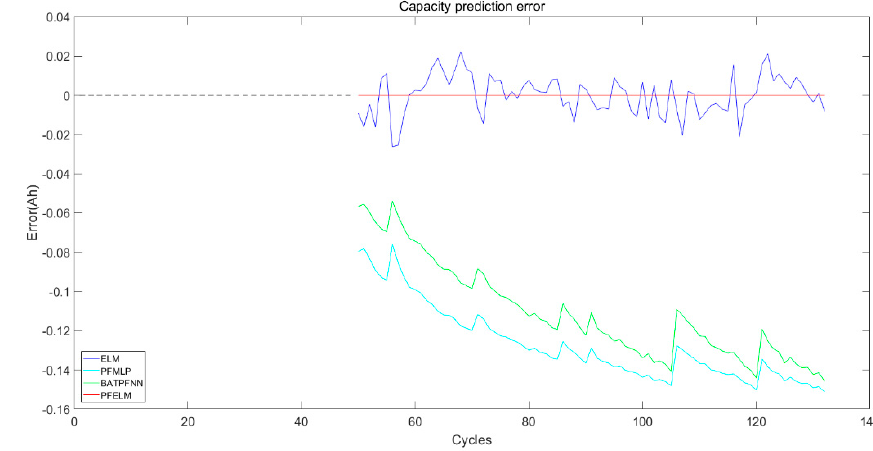
Figure 24. Predicting capacity from the 50th cycle by different algorithms: ( a ) ELM ; ( b ) PFMLP; ( c ) BATPFNN; ( d ) PFELM.